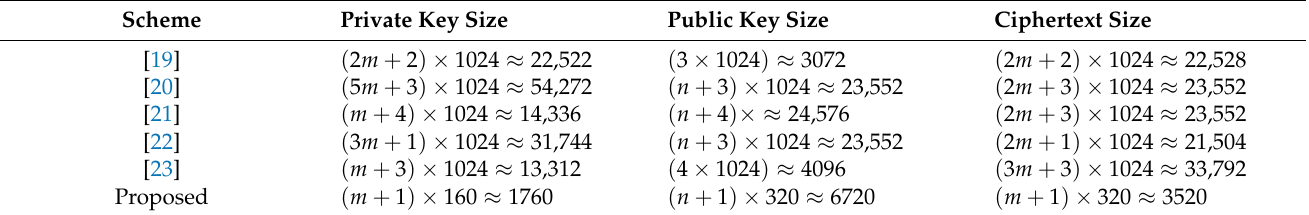
Table 3. Parameters size (bits).